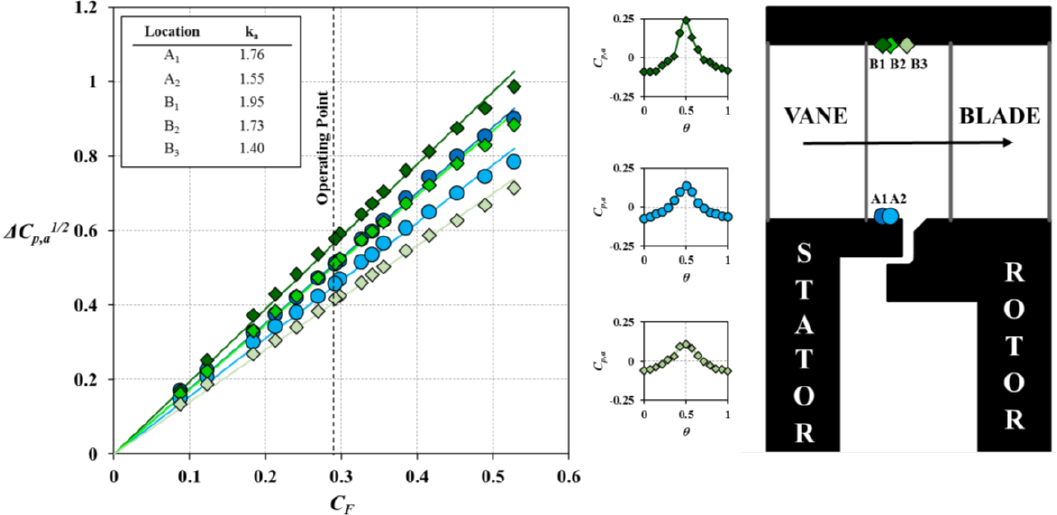
Figure 6. Variation of Δ C p,a 1/2 with flow coefficient C F in the annulus upstream of the rotor blades and selected circumferential distributions of non-dimensional pressure coefficient C p,a at the operating point ( Re φ = 7.2 × 10 5 , Φ 0 = 0).